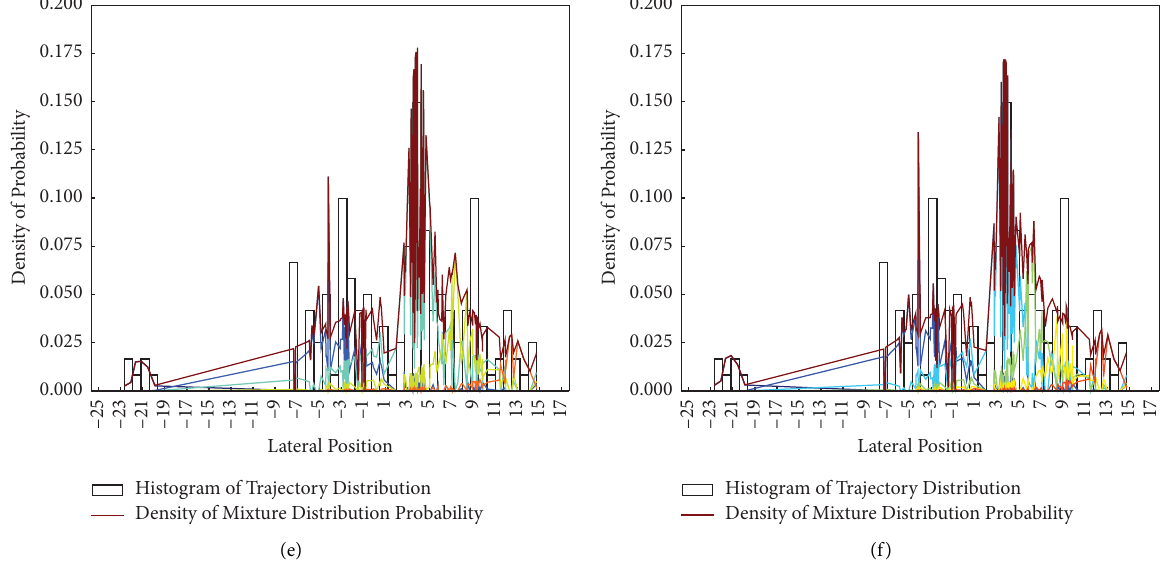
Figure 12: Fitting results of trajectory distribution on road cross-section based on WCGMM: (a) condition of one lane, (b) condition of two lanes, (c) condition of three lanes, (d) condition of four lanes, (e) condition of fve lanes, and (f) condition of six lanes.